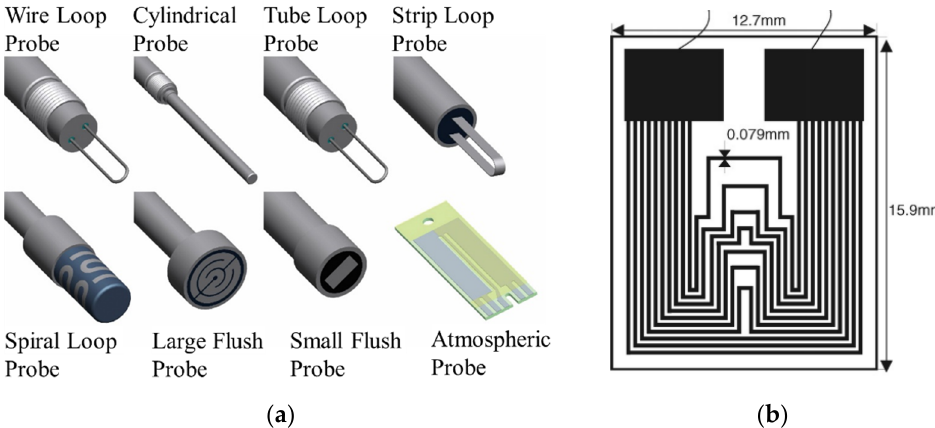
Figure 3. ( a ) Commercial electrical resistance (ER) sensing elements with different shapes [25] (Courtesy of Metal Samples Company); and ( b ) ER sensor with a multiple-line pattern of steel thin film which is sensitive to localized corrosion (Reprinted from Reference [26] with permission from Elsevier).